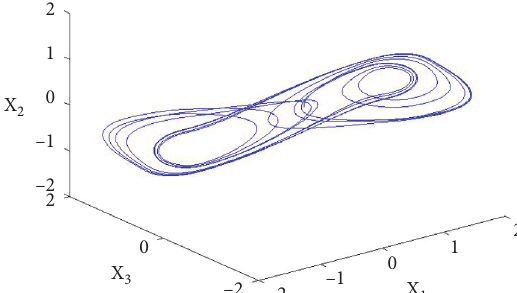
Figure 1: The trajectory of the synchronous state s ( t )